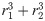
Time course of the relationship between each blood vessel segment thickness and frequency.(a) Retinal images obtained using whole-mount α-SMA immunohistochemistry. The tree-like structures of the artery were developed. (b) Relationship between r13+r23 and r33. The cubic sums appear to be constant, suggesting that these arteries obey Murray’s law. (c) Log–log plot of frequency versus thickness of each blood vessel segment. Scale bar = 1 mm.